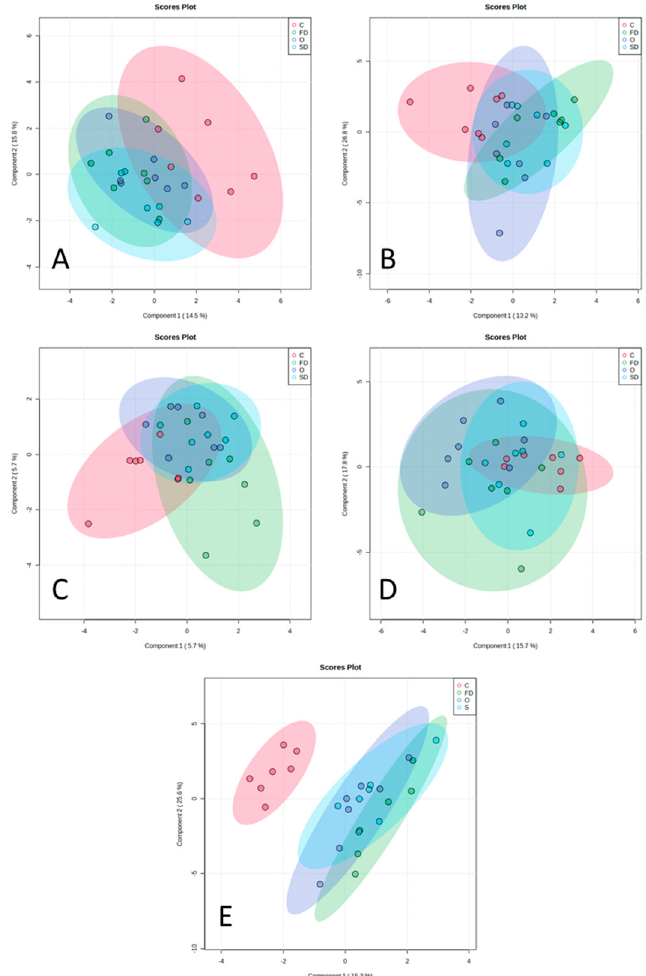
Figure 3. sPLSDA analysis including the FA + DMA profile. The different plots correspond to the different brain parts ( A – D ) and RTL tissues ( E ). ( A ) prefrontal cortex, ( B ) hippocampus, ( C ) grey matter, ( D ) white matter, and ( E ): RTL tissues. Diets are represented in different colours: red—C, control diet with no EPA sources; purple—O, diet with Nannochloropsis sp. oil; blue—SD, diet with spray-dried Nannochloropsis oceanica biomass; and green—FD, diet with freeze-dried Nannochloropsis oceanica biomass.